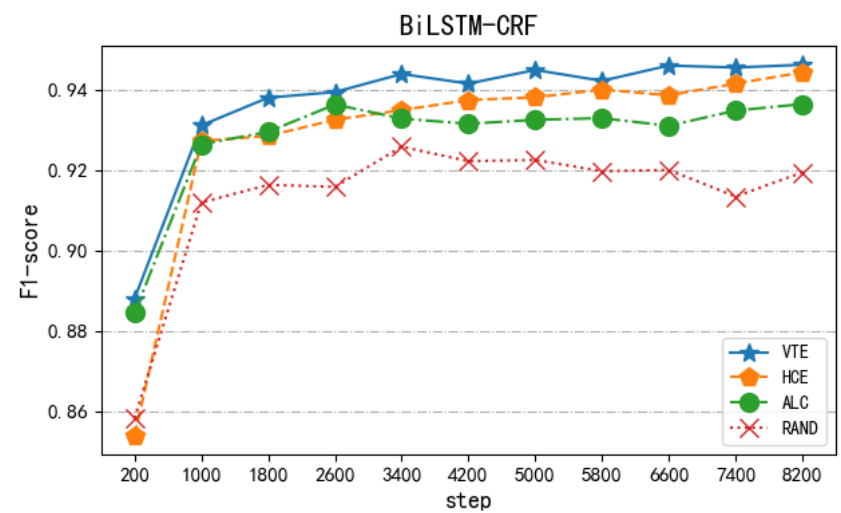
Figure 6. The performance of these algorithms based on the BiLSTM-CRF model.